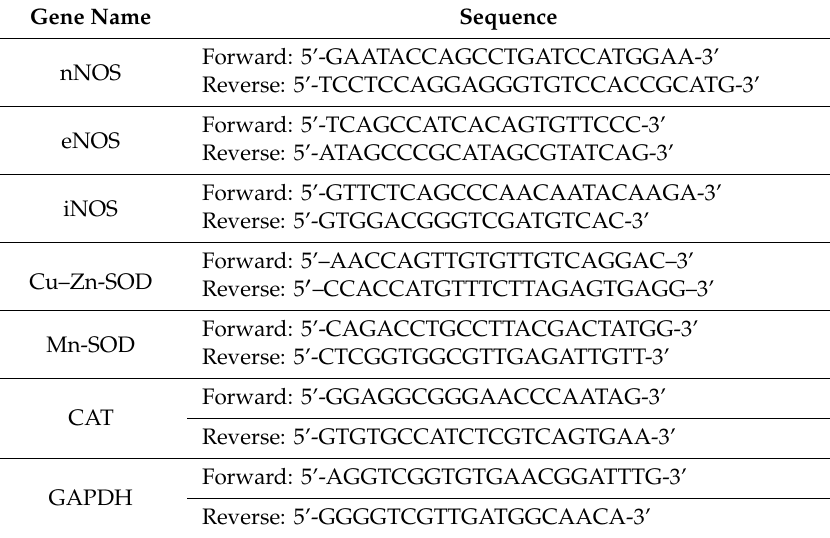
Table 1. Sequences of the primers used for RT-qPCR of the mice liver